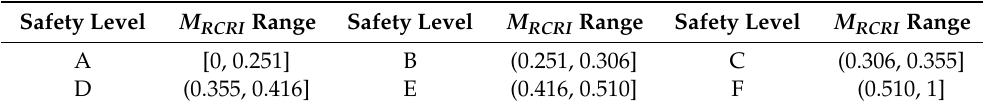
Table 1. Rear-end collision risk criteria.